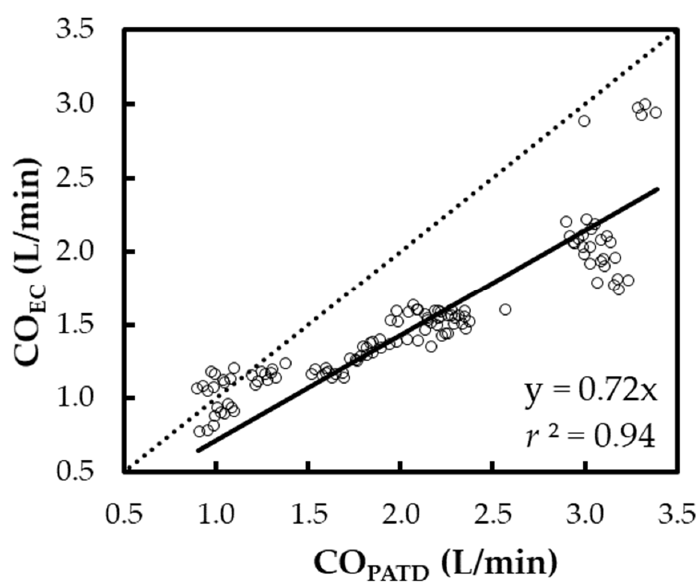
Figure 4. Scatter plot representing the cardiac output (CO) measurements using electrical cardiometry (CO EC ) and pulmonary artery thermodilution (CO PATD ) for six anesthetized Beagle dogs across five timepoints during four hemodynamic events (baseline, hemorrhage, autologous blood transfusion, and colloid infusion), thus yielding 120 paired observations (circles). Regression analysis about the line Y = X (dashed line) resulted in a good fit (solid line) as shown by the slope (0.72) and r 2 (0.94).